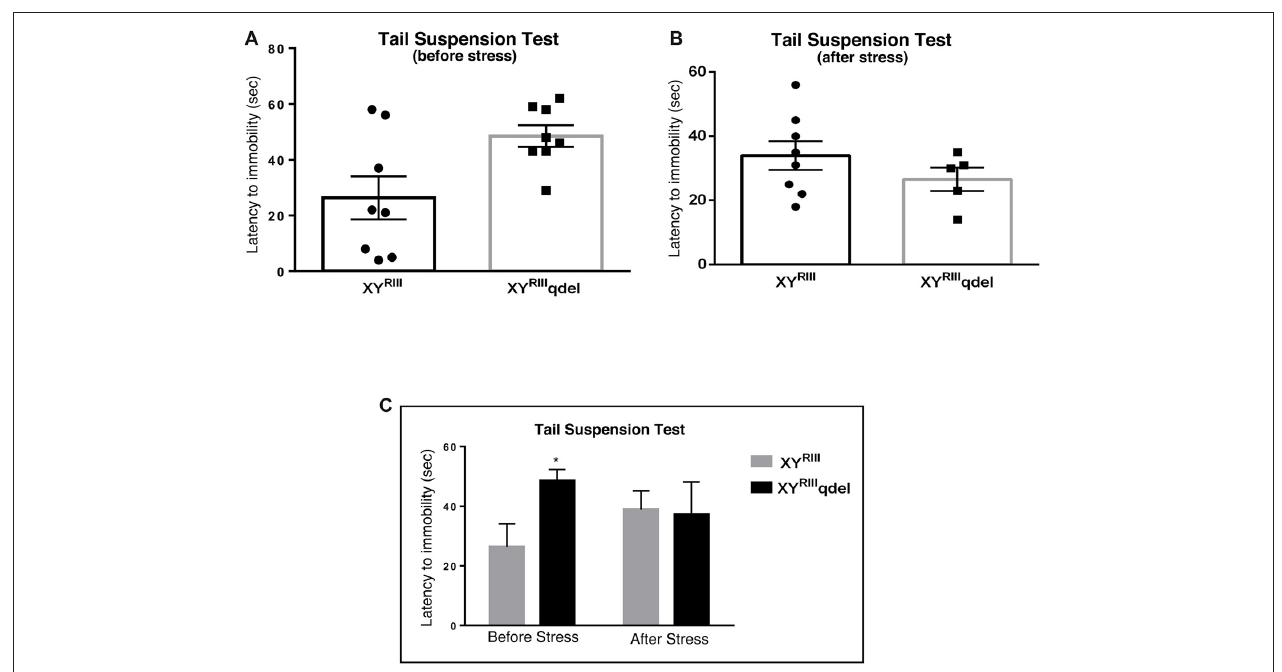
FIGURE 4 | The latency to immobility in XY RIII qdel and XY RIII mice was evaluated by tail suspension test before and after the exposure of the stressors. Before the mice have undergone stress paradigm, XY RIII qdel exhibited significant hyperactivity by showing remarkably more time in attaining first time immobility (A,C) . Please notice after stress this hyperactivity was leveled as shown by scatter bar plot (B) of the latency. Combined bar graph is shown to compare the effect of before and after stress in latency (C) . Data are expressed as the mean ± SEM, ∗ P < 0.05, n = 8–10 per group in before stress, n = 6–8 per group in after stress experiments.